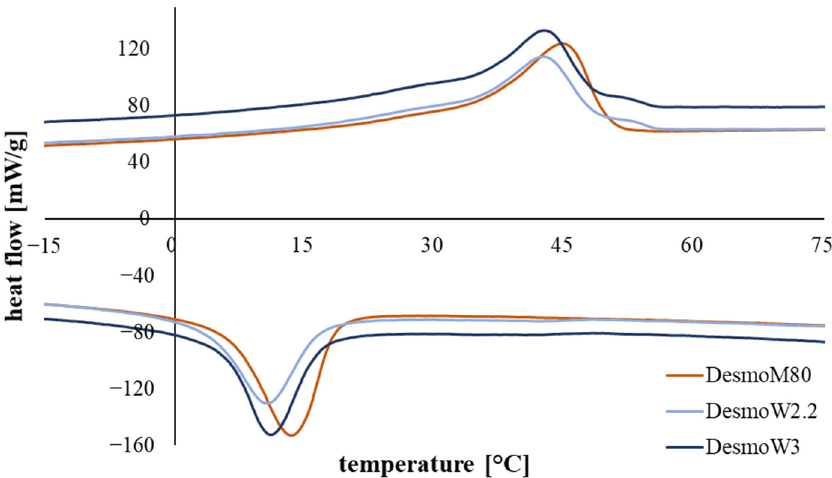
Figure 1. Display of the cooling and 2nd heating cycles of the three Desmopan yarns during DSC; a pronounced phase transformations of the switching phase starts at approx. 40 °C and peaks at 45 °C, respectively. (Re-)Crystallization starts at approx. 20 °C and peaks at 10–15 °C.